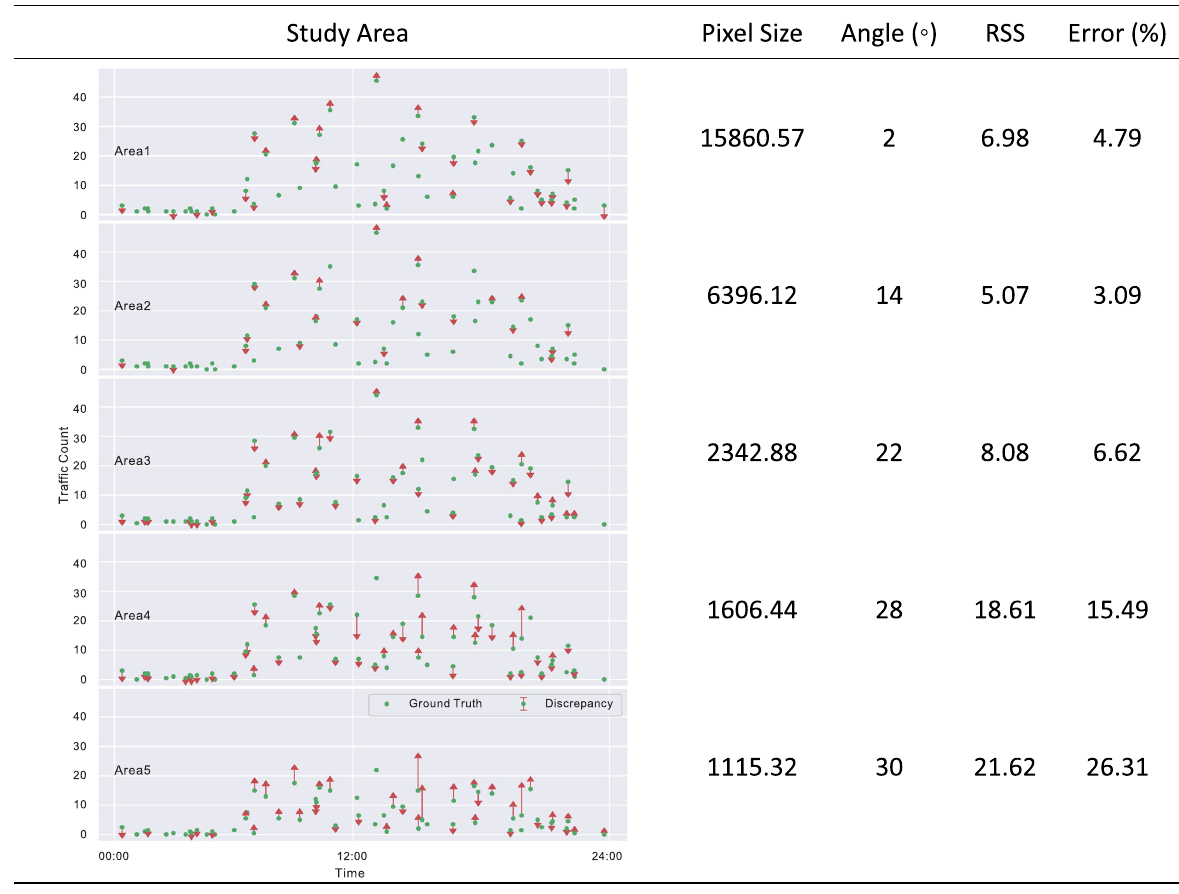
Fig. 6 Traffic count performance (RSS and error percentage) and statistics (camera angle and pixel size) for 5 different study areas. In each area subgraph, circles represent the ground truth traffic counts, the corresponding ending points of the arrows indicate the measurements, and the lengths of each arrow are the